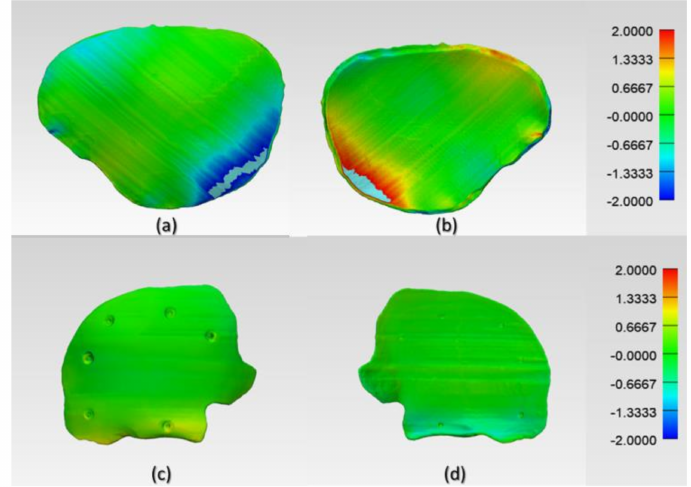
Figure 8. Color-coded deviation maps illustrating the areas of congruence or incongruence between planned and FFF 3D printed PEEK PSIs. Group 1 PSI: ( a ) squamous (outer) surface and ( b ) cerebral (inner) surface and Group 2 PSI: ( c ) squamous (outer) surface and ( d ) fronto-orbital (inner)